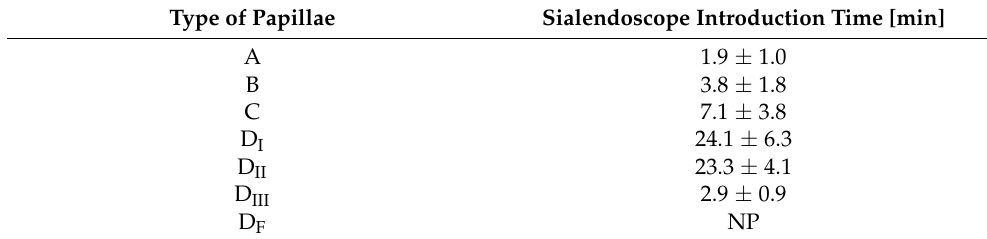
Table 3. Time required for the introduction of the